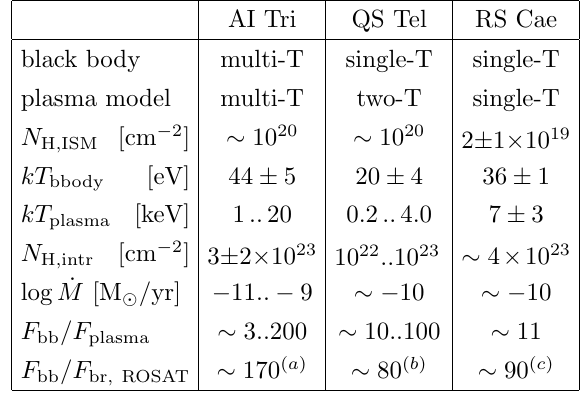
Table 1: Parameters of the best fits to the XMM- Newton spectra. Bolometric ROSAT flux ratios at fixed temperatures are calculated from ( a ) Schwarz et al. 1998, ( b ) Schwope et al. 1995, ( c ) Burwitz et al. 1996, applying corrections of κ bb = 2 . 5, κ br = 4 .